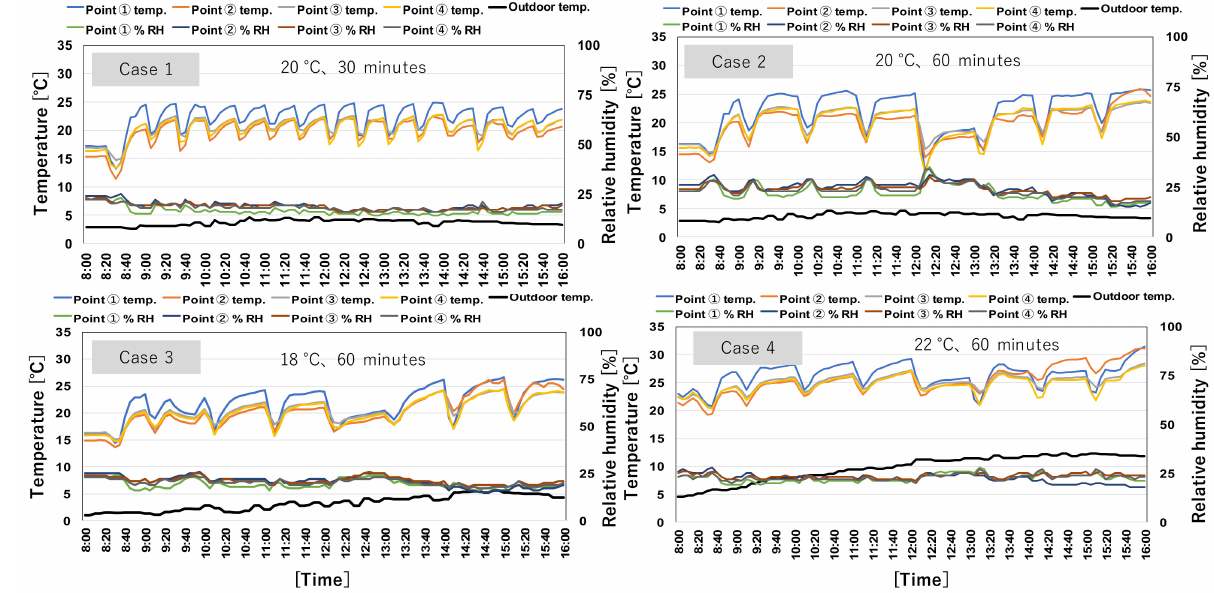
Figure 7. Changes of indoor temperature and relative humidity in